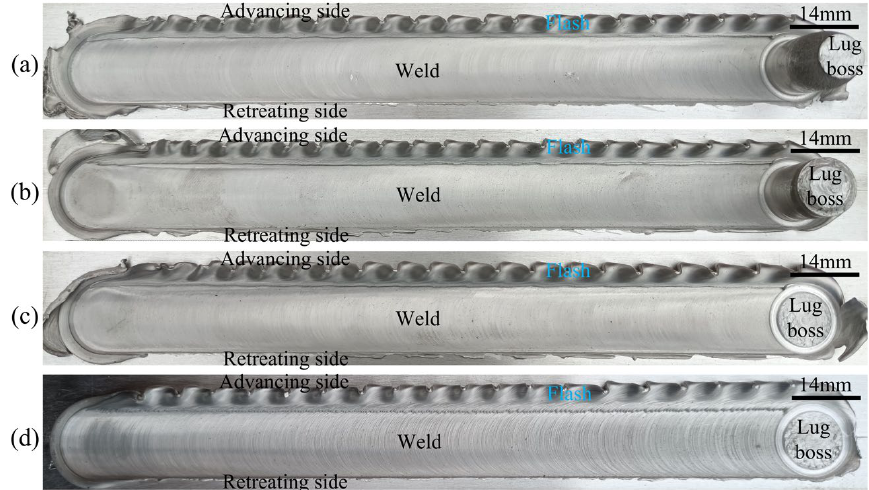
Figure 5. Effect of the rotation speed on the weld morphology: ( a ) ω = 700 rpm; ( b ) ω = 800 rpm; ( c ) ω = 900 rpm; ( d ) ω = 1000 rpm; ( v = 30 mm/min, d = 12 mm).